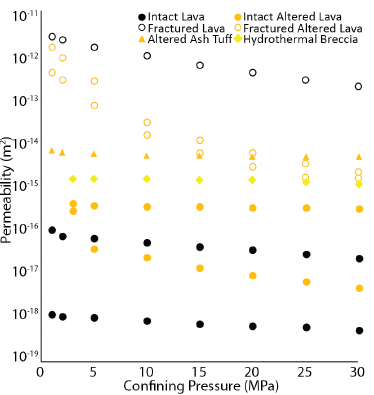
Figure 7. Permeability as a function of confining pressure showing the different impacts of confining pressure on altered and unaltered, fractured and unfractured samples.